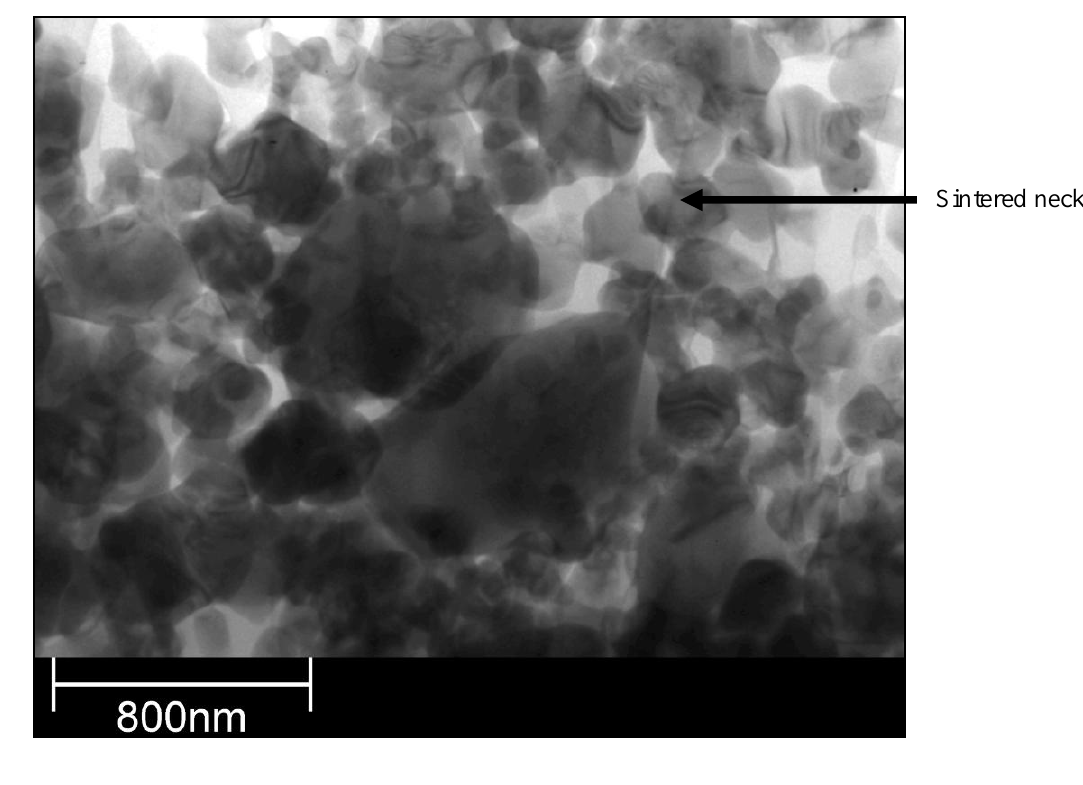
Figure 19. Transmission electron micrograph of an agglomerated zone of HA coating obtained by suspension plasma spraying